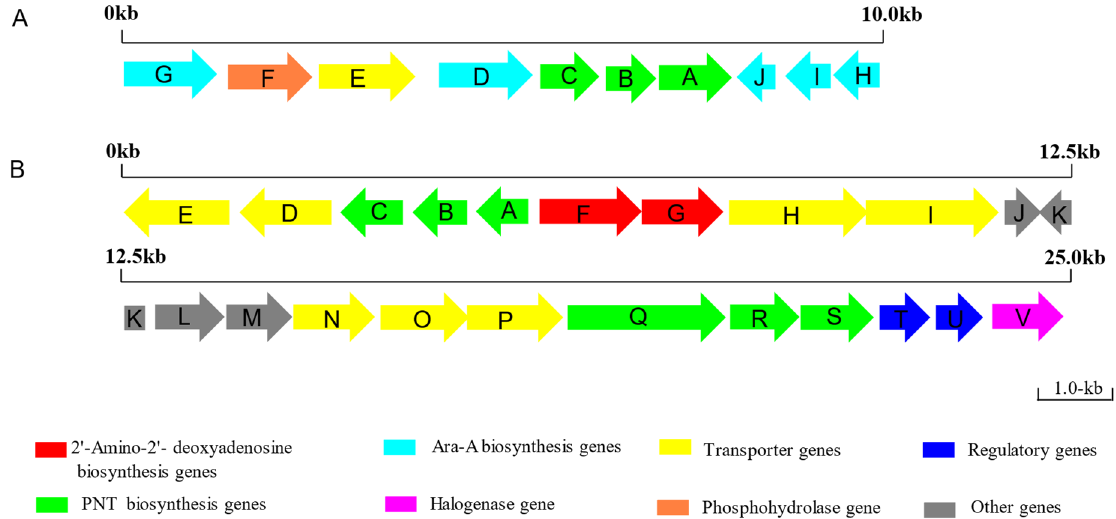
Figure 3. The biosynthesis gene cluster of PNT and associated products in the Streptomyces antibioticus NRRL 3238 and Actinomadura sp. ATCC39365. ( A ): The biosynthesis gene cluster in Streptomyces antibioticus NRRL 3238. ( B ): The biosynthesis gene cluster in Actinomadura sp. ATCC39365. Table 2. The proposed functions of proteins in the biosynthesis gene cluster of PNT and Ara-A in the Streptomyces antibioticus NRRL 3238.